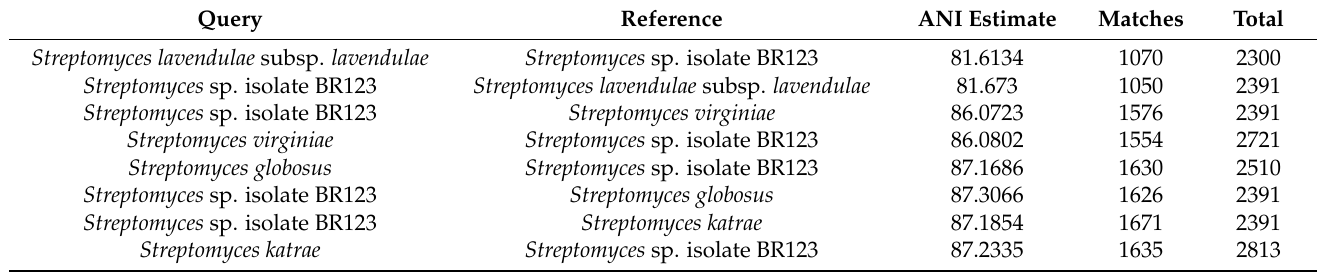
Table 2. Average nucleotide identity (ANI) between all Streptomyces species used in this study. Query